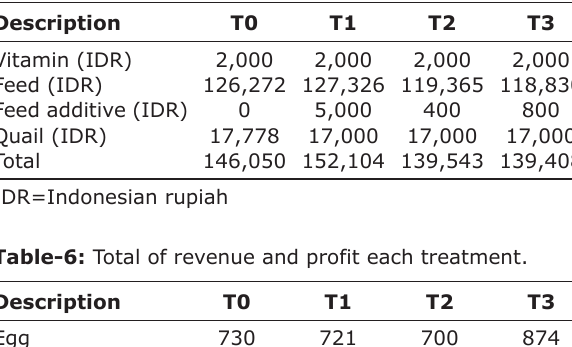
Table-5: Variable cost of treatment.